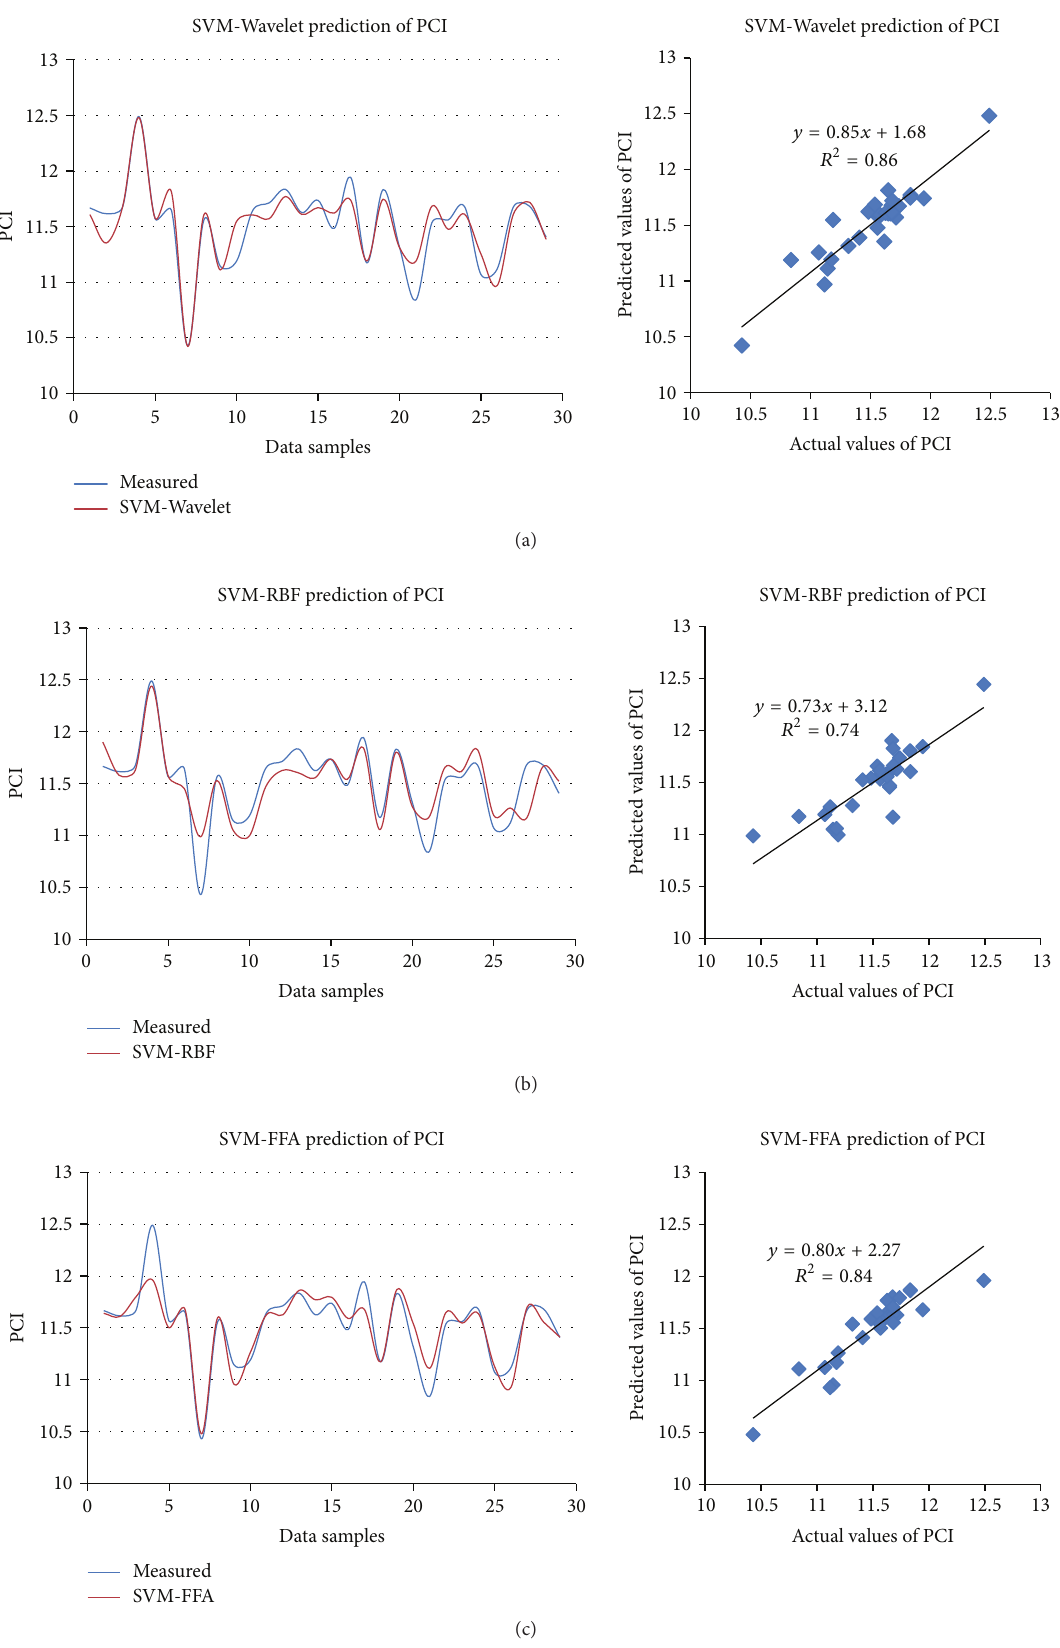
Figure 7: Scatter plots of actual and predicted values of PCI using (a) SVM-Wavelet, (b) SVM-RBF, and (c) SVM-FFA